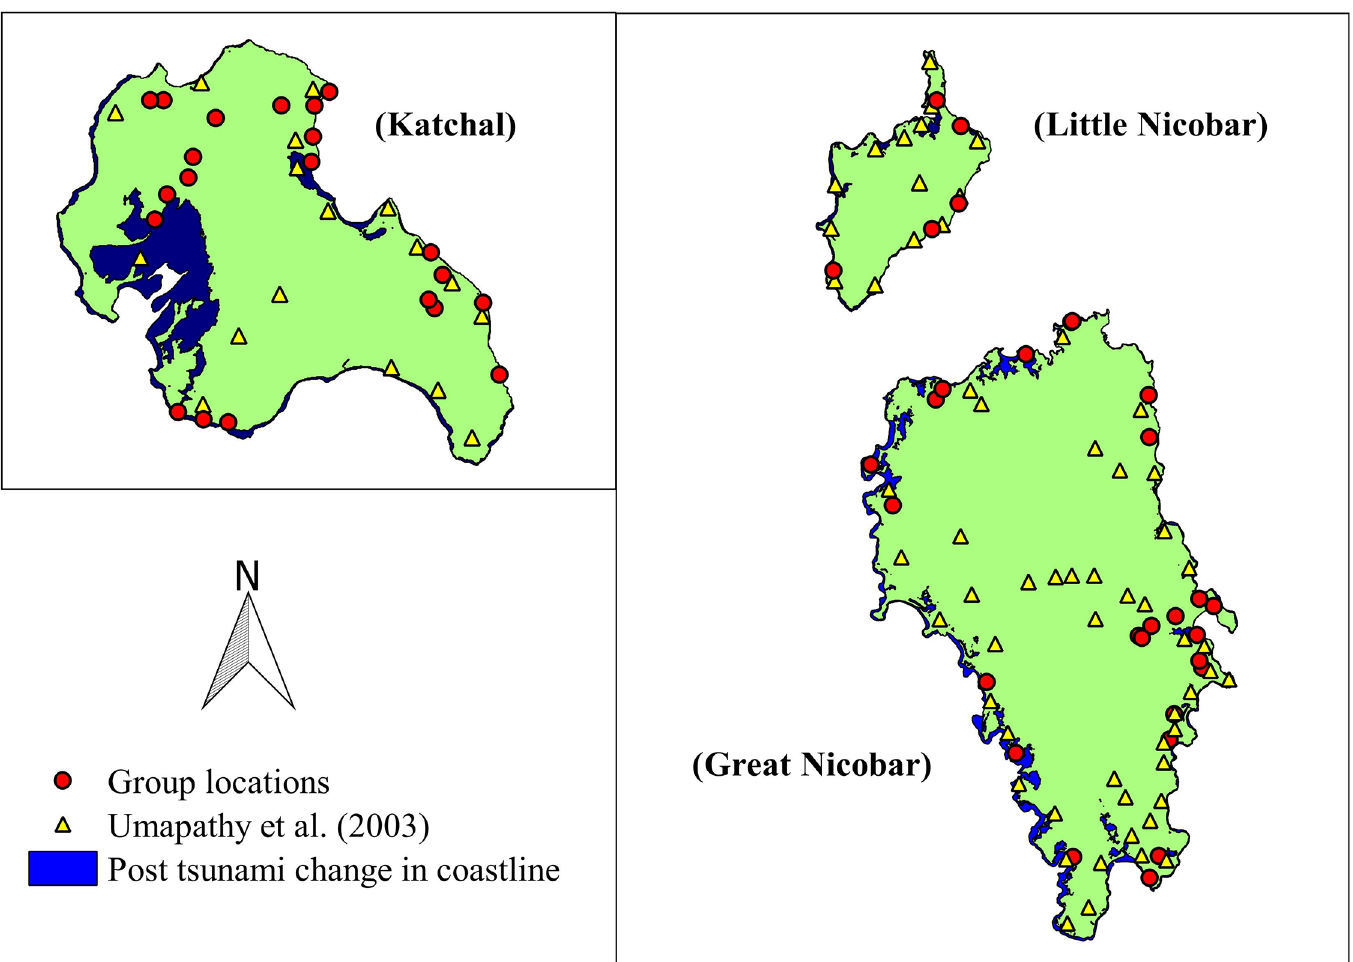
Fig 2. Map of Nicobar Islands depicting inundated area due to tsunami and group location of current study with group locations of pre-tsunami study.